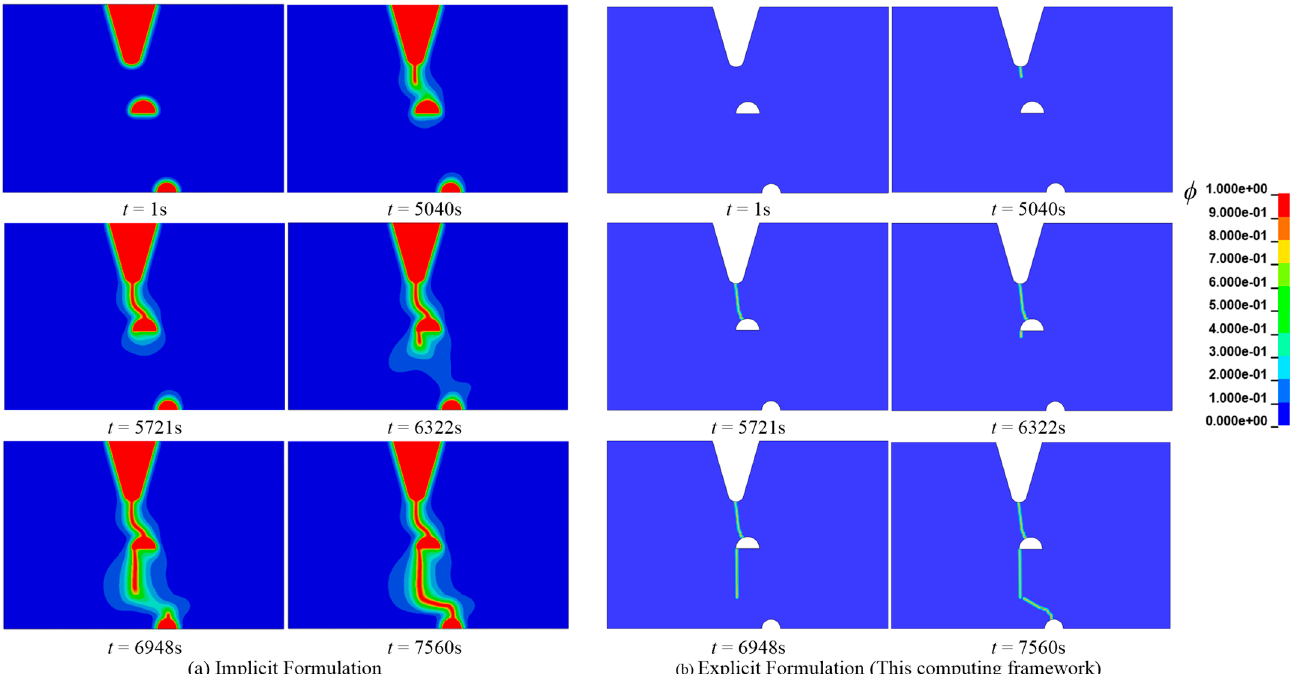
Figure 15. Model and mesh in Case 3.